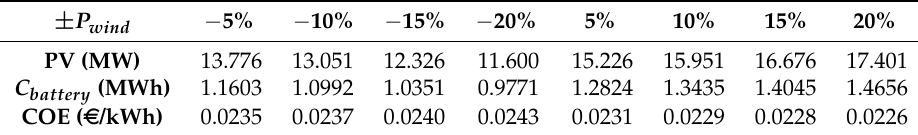
Table 2. Effect of wind power on the sizes of PV and